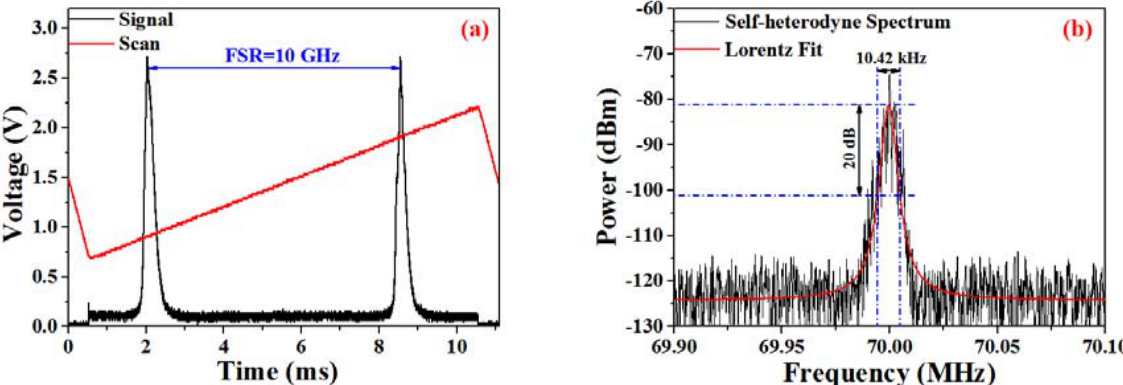
Figure 2. ( a ) Scanning FPI verifying single-frequency operation spectrum; ( b ) Measured and fitted lineshape of the self-heterodyne signal.